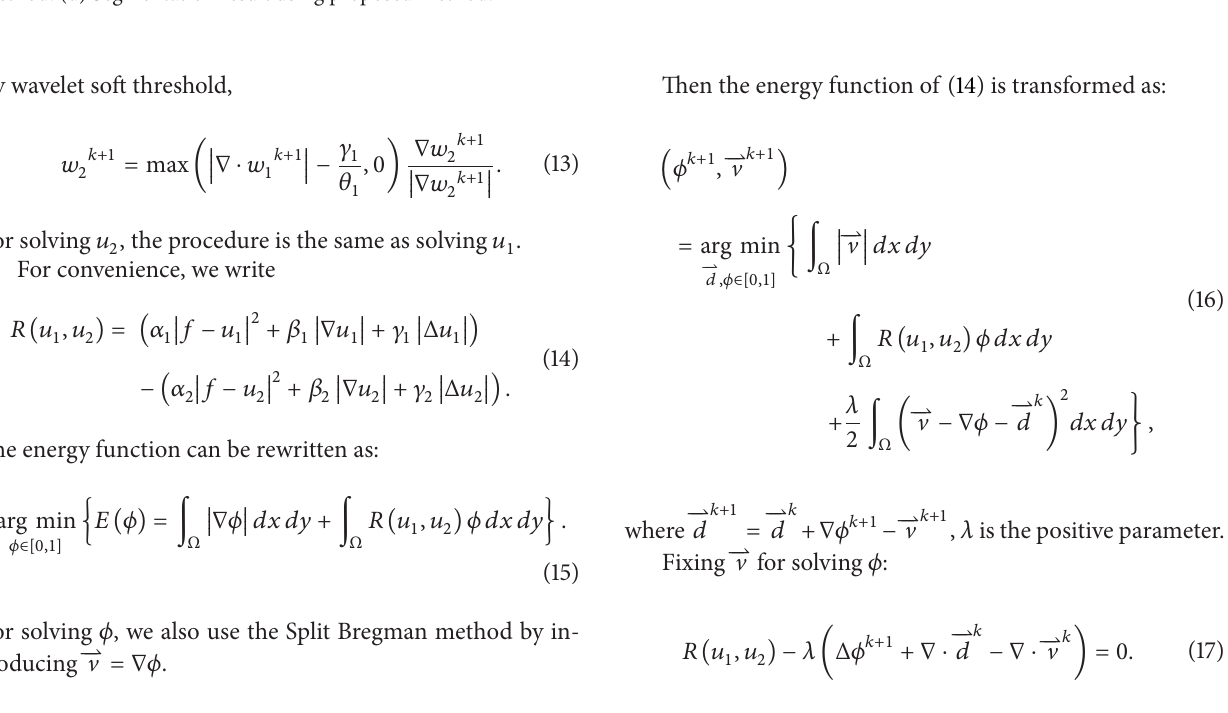
Figure 3: Image for segmentation. (a) Original image. (b) Segmentation result using CV model. (c) Segmentation result using mean shift method. (d) Segmentation result using proposed